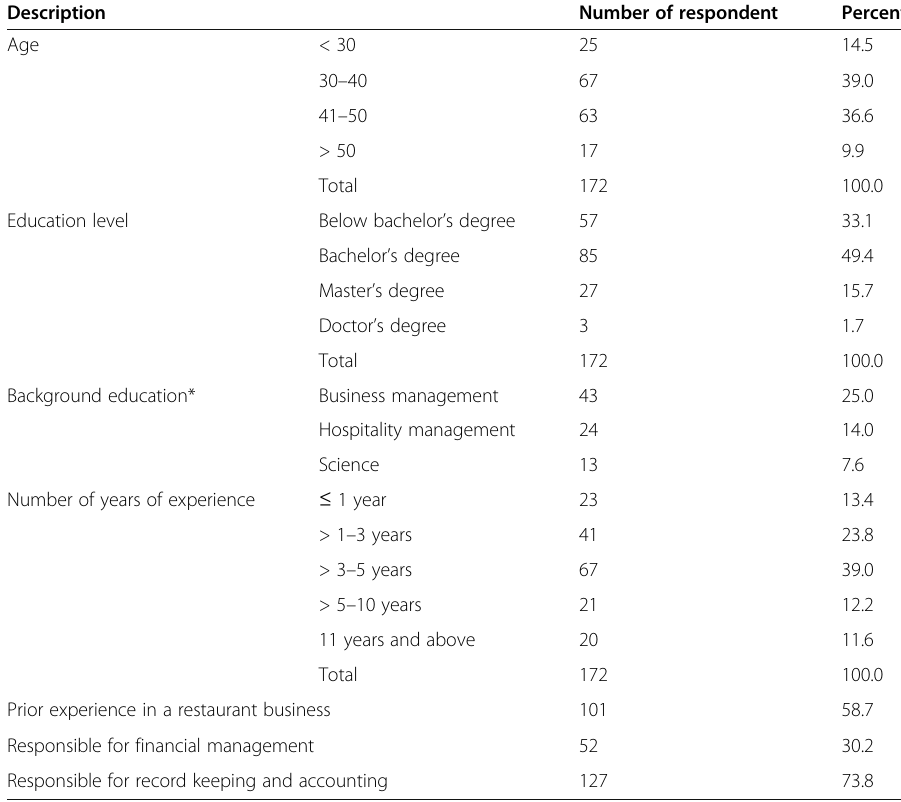
Table 1 Demographic characteristics of the respondents Description